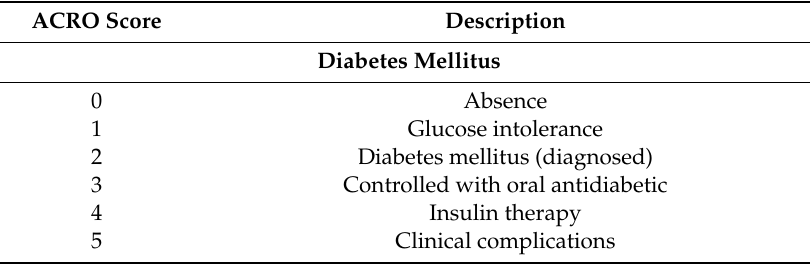
Table 2. Evaluation of obesity-related comorbidities